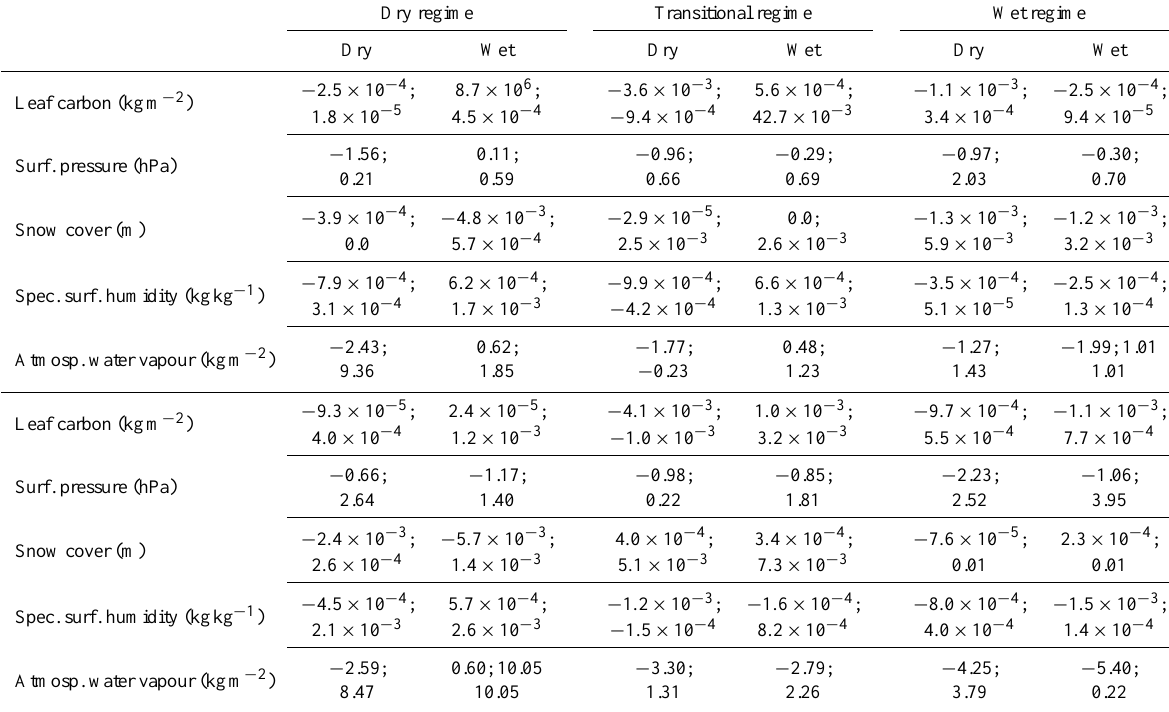
Table 5. Range of area-weighted mean values of (cid:49)θ 0 (upper part) and (cid:49)θ max (lower part) for different soil moisture regimes and initializa- tions. The semicolon separates minimum and maximum values occurring for different seasons and hemispheres.